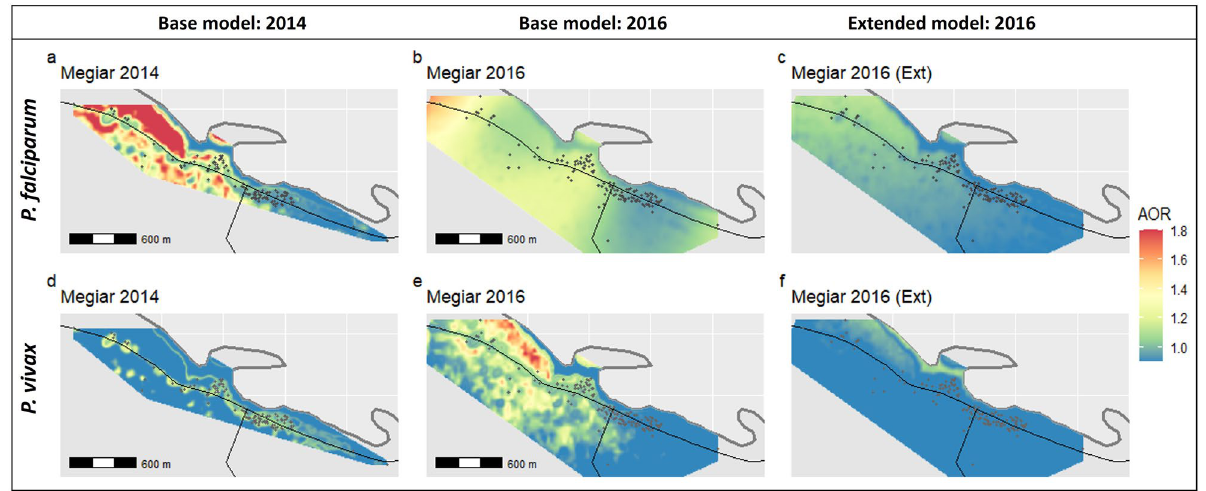
Figure 3. Variable spatial effect of predicted adjusted odds ratios (AOR) for P. falciparum and P. vivax infection derived from generalised additive models (GAM) in Megiar. Base model covariates age, sex, LLIN usage and NDVI were applied in the GAM for 2014 and 2016 ( a , b , d , e ). Base model covariates combined with household covariates (extended model) were applied in the GAM in 2016 ( c , f ) to investigate the contribution of household risk factors to spatial risk. Spatial distribution of sampled households shown in grey points in both the 2014 and 2016 base models. Megiar is a coastal village, thick grey lines represent the coastline and thin black lines represent the main road. Maps were created in R v.3.6.2 (https:// www.R- proje ct.